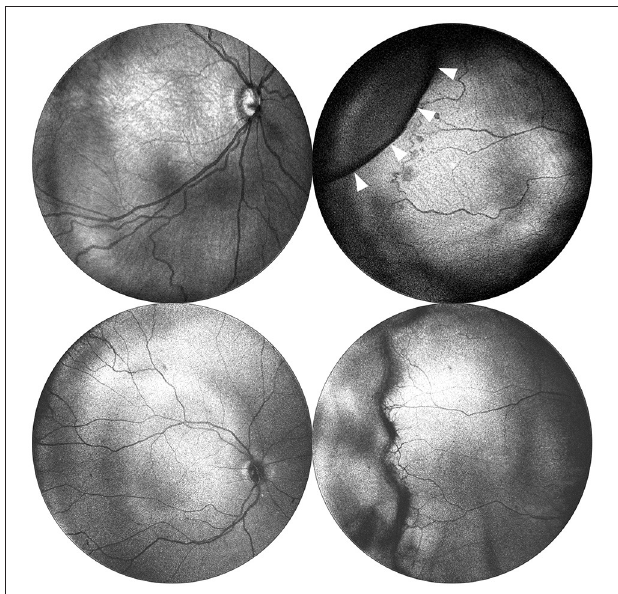
FIGURE 2 | Posterior and peripheral en face images obtained via portable 55 ◦ and 105 ◦ FOV OCT. Images in the top row were obtained using a 55 ◦ FOV system from a baby born at 24 weeks gestation (770 grams) and imaged at 33 weeks postmenstrual age. The images in the bottom row were obtained using a 105 ◦ FOV system from a baby born at 30 weeks gestation (1,390g), and imaged at 40 weeks postmenstrual age. Posterior images are shown in the left column and demonstrate the expanded FOV. Peripheral images are shown in the right column and were obtained with the aid of scleral depression using the 55 ◦ system. White arrows indicate the indentation of the scleral